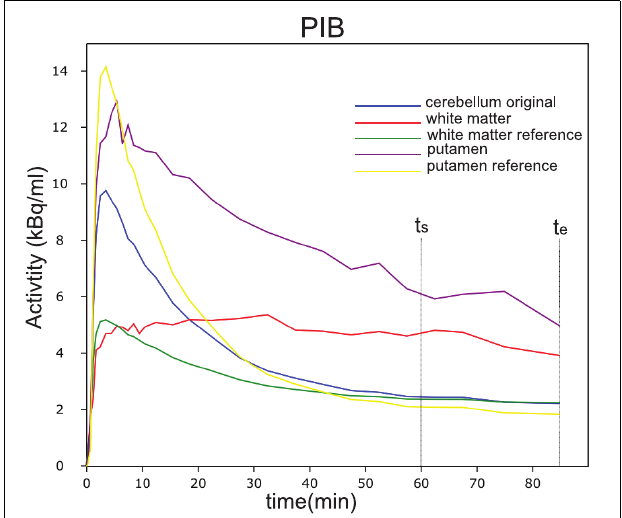
FIGURE 2 | Time activity curves of PIB from a single subject in different regions of interest (ROI). In blue is shown the measured cerebellar reference curve. The purple and yellow curves are the putamen curves as well as the estimated reference curve. The red and green curves are the curves for a small white matter region and the corresponding estimated reference curve.